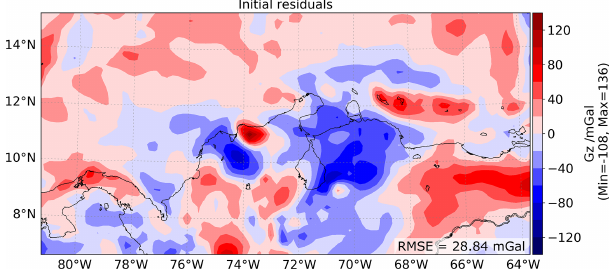
Figure 6. Gravity residuals of the initial lithospheric configuration, assuming the densities in Table 1. Here, large misfits with a domi- nance of short (few kilometres) and medium (hundreds of kilome- tres) wavelengths suggest density heterogeneities in the shallower domains of the lithosphere that were not considered in the initial set-up of the model. Table 2. Summary of the layers and density values that integrate the final structural model of the South Caribbean and north-western South American